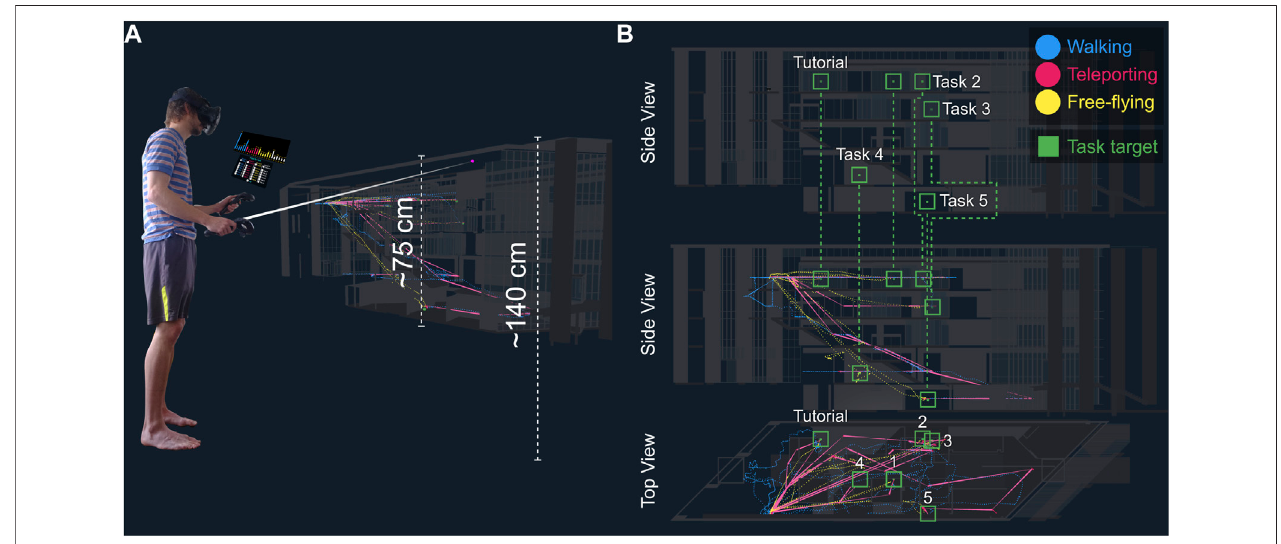
FIGURE 7 | (A) : A user with model and data visualization during Re fl ective phase. (B) : Three views of a user ’ s data in the Re fl ective phase. Green cubes in the visualization show the destination for each task. Blue, pink, and yellow visualize walking, teleporting, and free- fl ying, respectively.